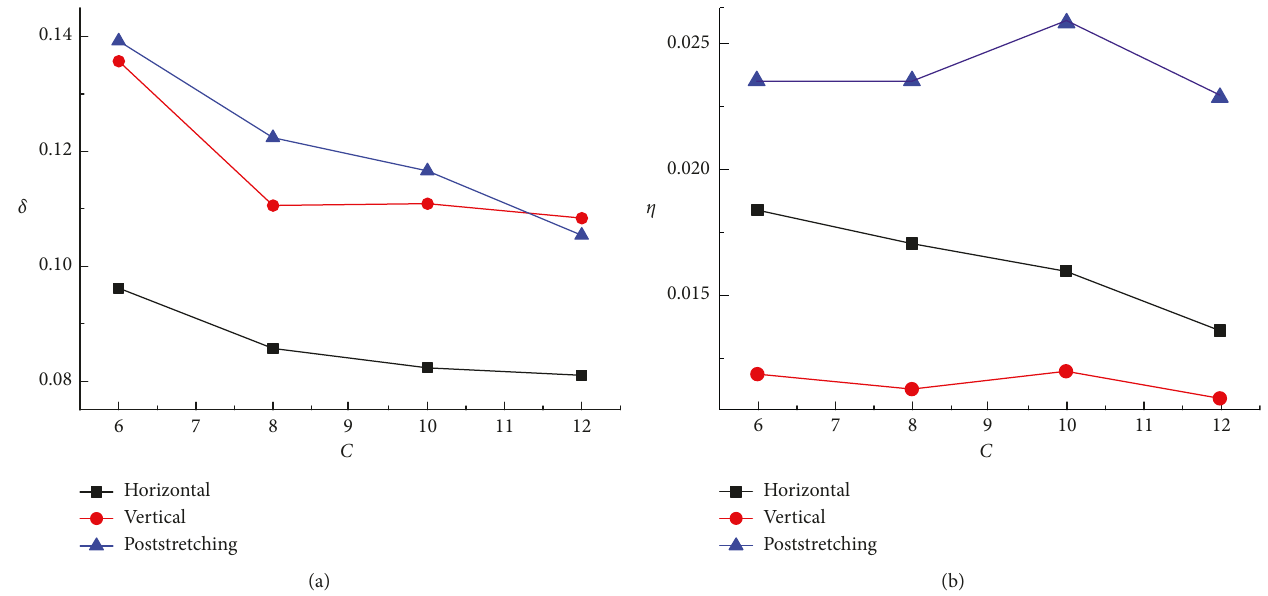
Figure 13: Influence of the number of die on cross-sectional distortion during each process.